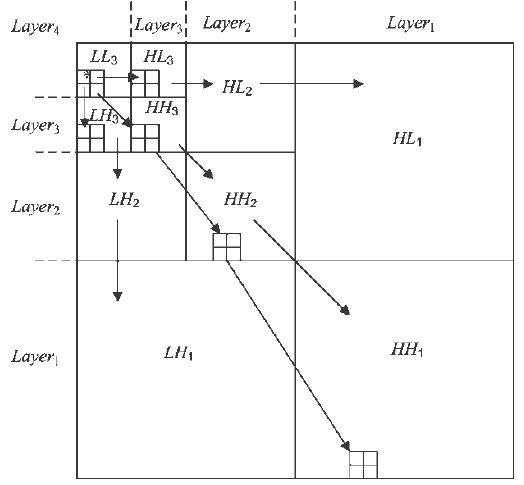
Fig. 4 Example of the three-scale pyramidal decomposition of an image and the tree structure. The SPIHT uses the tree structure, where a parent node has four child nodes except the nodes in Layer 1 and in Layer 4 .